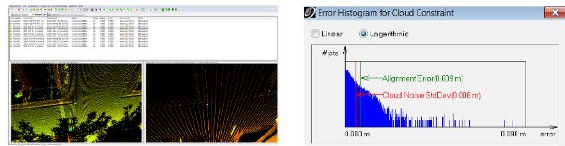
Figure 7. Morphology scan alignment by Cyclone Register and the graph which shows the alignment